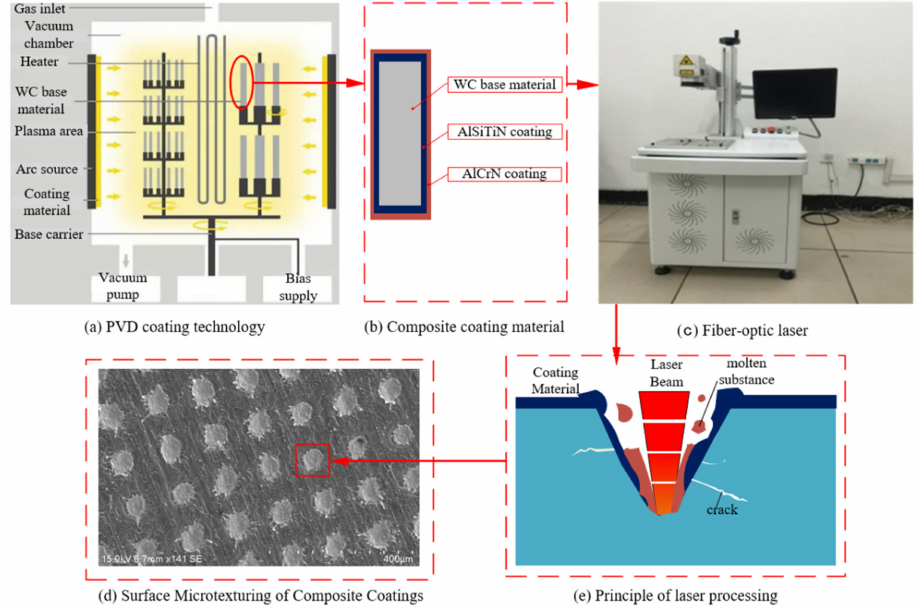
Figure 1. Coating technology and micro-texture preparation principles. ( a ) is PVD coating technology, ( b ) is Composite coating material, ( c ) is Fiber-optic laser, ( d ) is Surface Micro texturing of Composite Coatings, ( e ) is Principle of laser